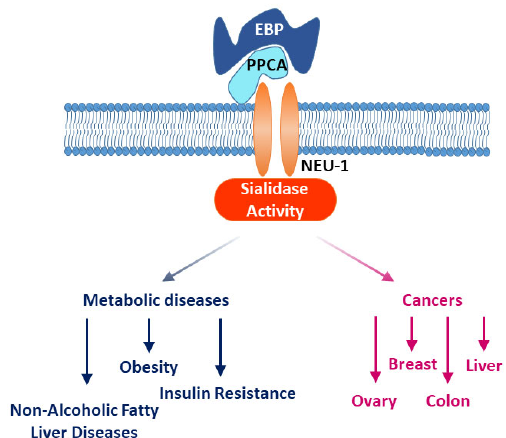
Figure 1. Role of NEU-1 in cancers and metabolic disorders. EBP: Elastin Binding Protein, PPCA: Protective Protein or Cathepsin A, NEU ‐ 1: Neuraminidase ‐ 1.